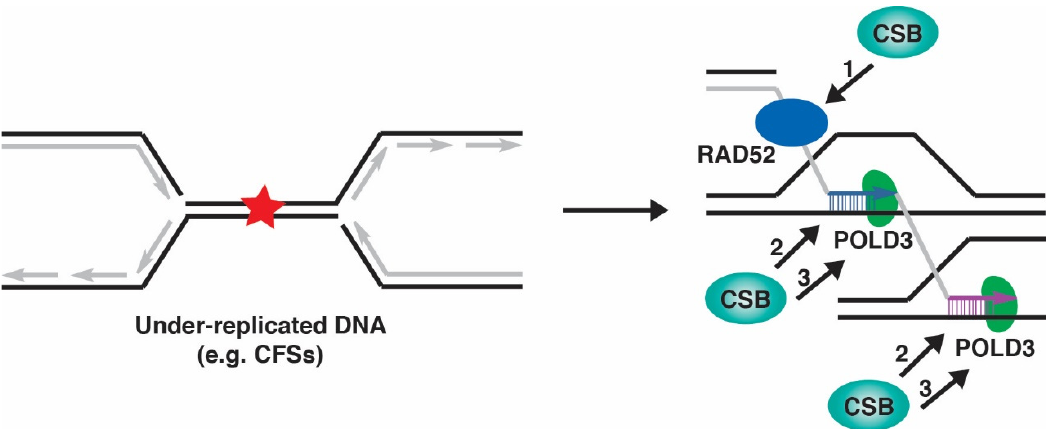
Figure 3. CSB promotes MiDAS through several possible mechanisms. CSB could act in parallel to facilitate RAD52-mediated strand annealing (arrow 1). CSB could prepare DNA substrates suitable for POLD3-mediated DNA synthesis (arrow 2). CSB could recruit POLD3 to sites of DNA synthesis to promote MiDAS (arrow 3).